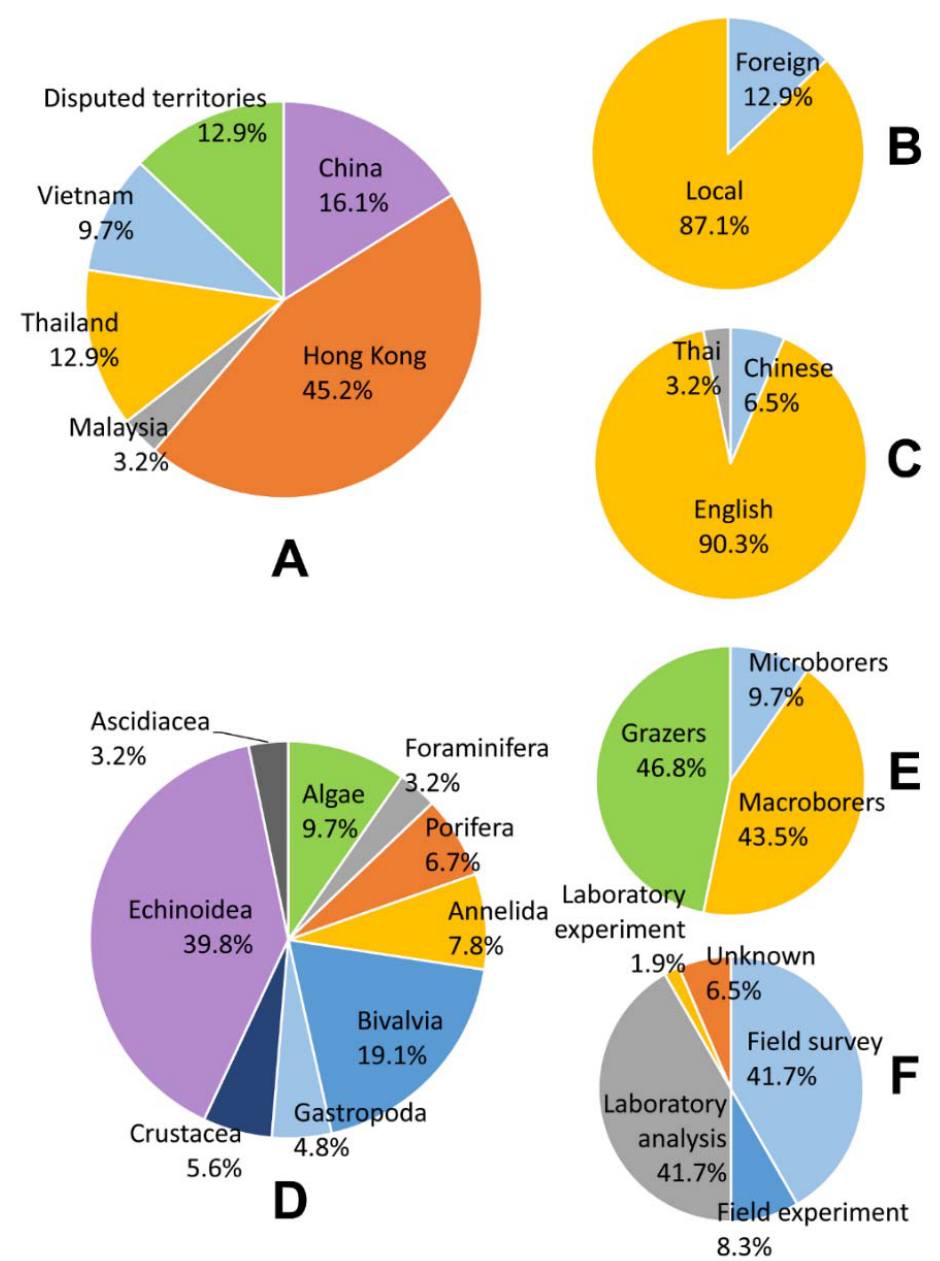
Figure 3. Proportional publications on bioerosion in the South China Sea based on a Google Scholar search using the search term ‘bioerosion AND “South China Sea”’, yielding 31 publications between 1982 and early 2022. ( A – C ) Proportional research culture. ( A ) Country of study or sampling. ( B ) Country of affiliation of first author. ( C ) Language of publication. ( D , E ) Proportional research target and method. ( D ) Studied taxon groups. ( E ) Bioeroder guilds, eco-function. ( F ) Research methods.